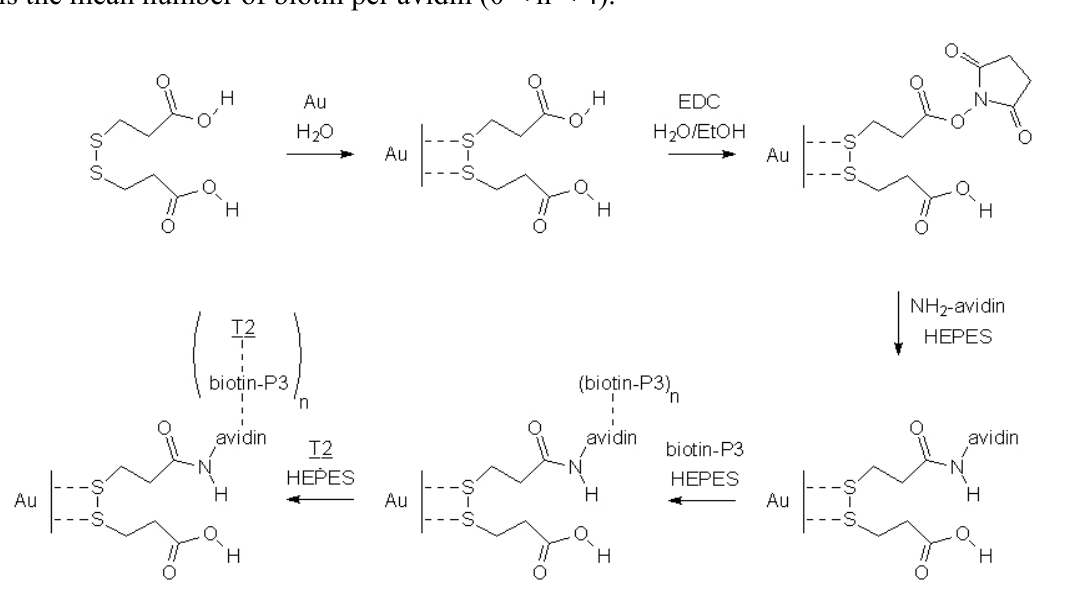
Figure 4. Avidin grafting, biotin-labeled probe (P3) grafting and target (T2) hybridization. n is the mean number of biotin per avidin (0 < n < 4).